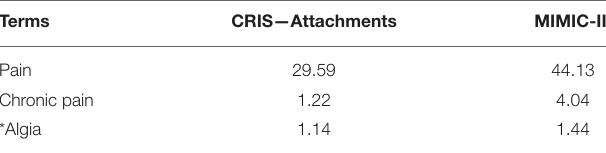
TABLE 1 | Count of mentions of “pain”, “chronic pain,” and “-algia” per 10,000 tokens (counts for “pain” include “chronic pain” instances too).